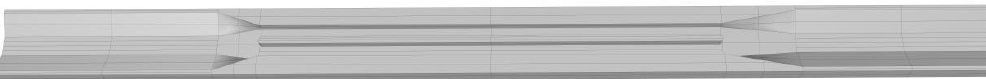
Figure 2. Three-dimensional layout of the aqueduct.